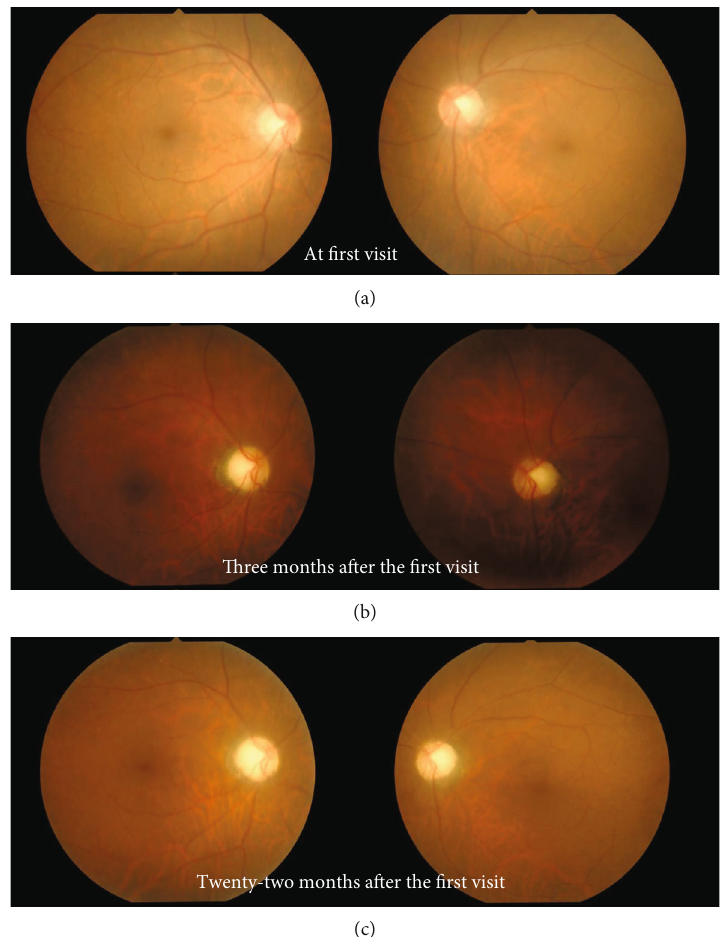
Figure 1: Fundus photographs. (a) At the fi rst visit, funduscopy showed an almost normal appearance in both eyes. (b) Three months after the fi rst visit, funduscopy showed optic disc pallor in both eyes. (c) Twenty-two months after the fi rst visit, the optic disc pallor remained